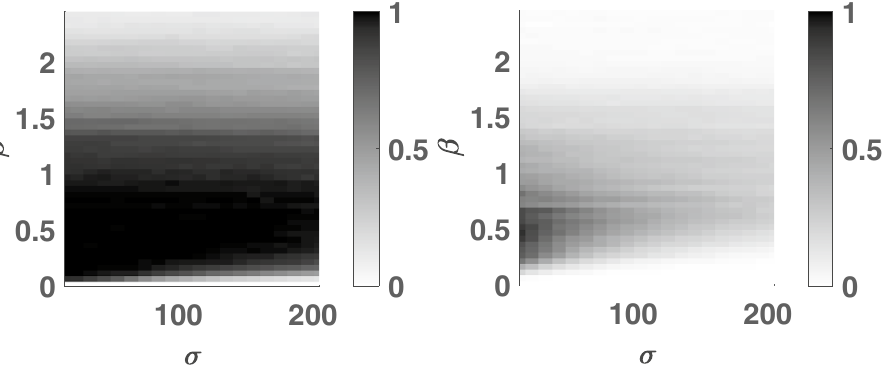
Figure 4. The reservoir computer is somewhat robust to noise. The effects of σ and β are shown. Left: 4th order parity task. Right: 6th order parity task. Parameters were set such that: µ = 5 , A = 0.5 , � = 40 π rad/s, ω 0 = 40 π rad/s, T p = 0.1 seconds, N = 1000 nodes, and φ = π/ 3 rad.